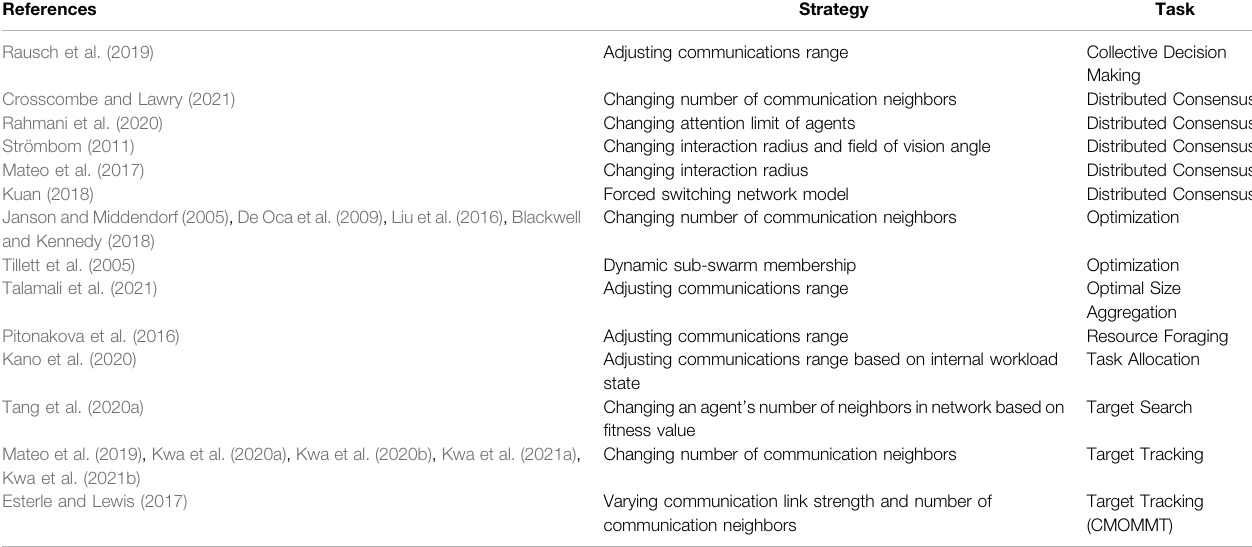
TABLE 8 | List of works using different information dissemination strategies to in fl uence the level of exploration and exploitation of an MAS or